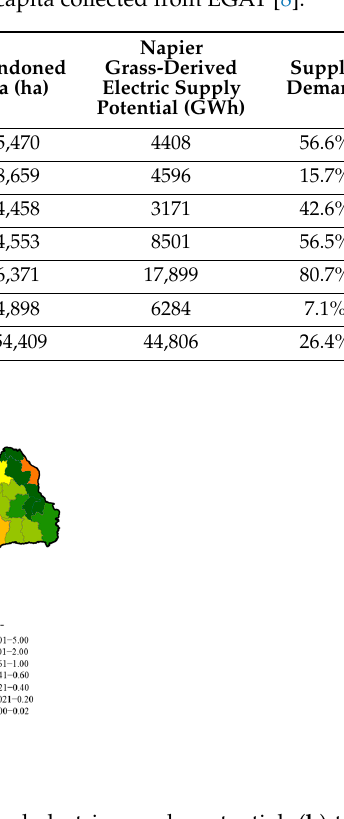
Table 5. The regional electric consumption, population, and electric consumption per capita collected from EGAT [8].